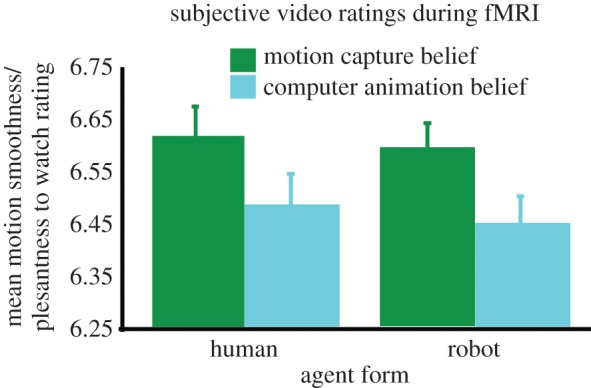
Behavioural data from fMRI task. Plots illustrate mean ratings reported by participants to questions interrogating how smooth participants found the movements or how much they enjoyed watching them. A main effect of belief was manifest, such that participants found those action videos they believed to originate from human motion capture techniques to be smoother and more enjoyable to watch than videos they believed to originate from computer-generated animation. No other main effects or interactions were observed.